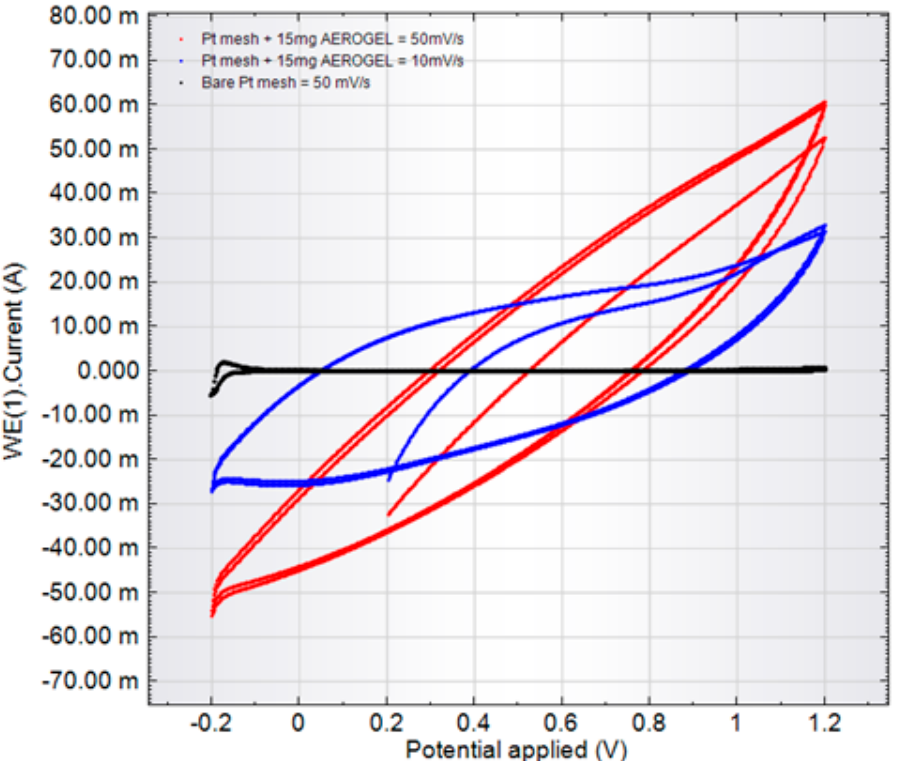
Figure7. Figure 7. Voltammograms of samples of the experimental supercapacitor electrode from RF-1000 aerogel.